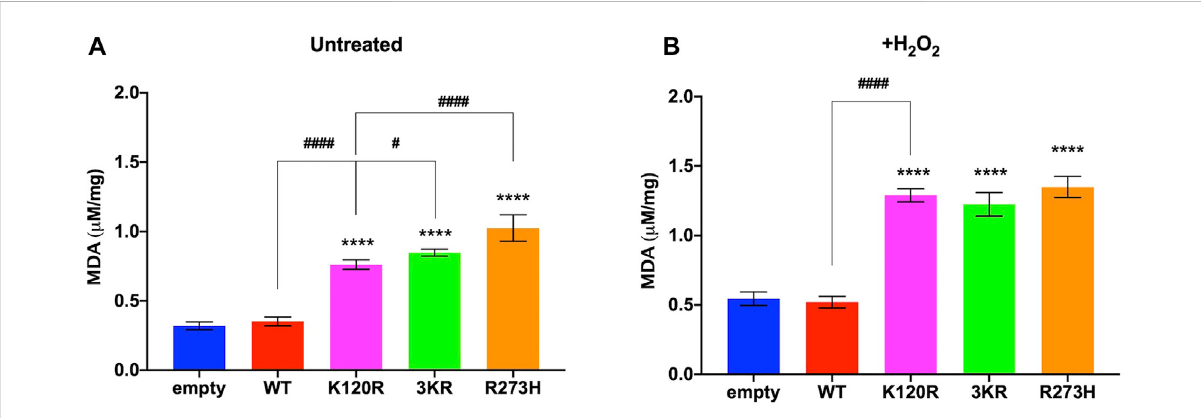
FIGURE 7 EvaluationofoxidativestressinuntreatedandH 2 O 2 treatedHCT 116 TP53 − / − cellsexpressingp53 WT ,p53 3KR ,p53 K120R ,andp53 R273H proteins. (A) MDA level in untreated cells. (B) MDA level in 100 μ M H 2 O 2 treated cells. The panels are representative of at least four independent experiments and data are reported as mean ± SD. The symbol **** indicates signi fi cant differences for p < 0.0001 between empty and the other samples; the symbols # and #### indicate signi fi cant differences for p = 0.0445 and p < 0.0001, respectively, between p53 K120R and the indicated